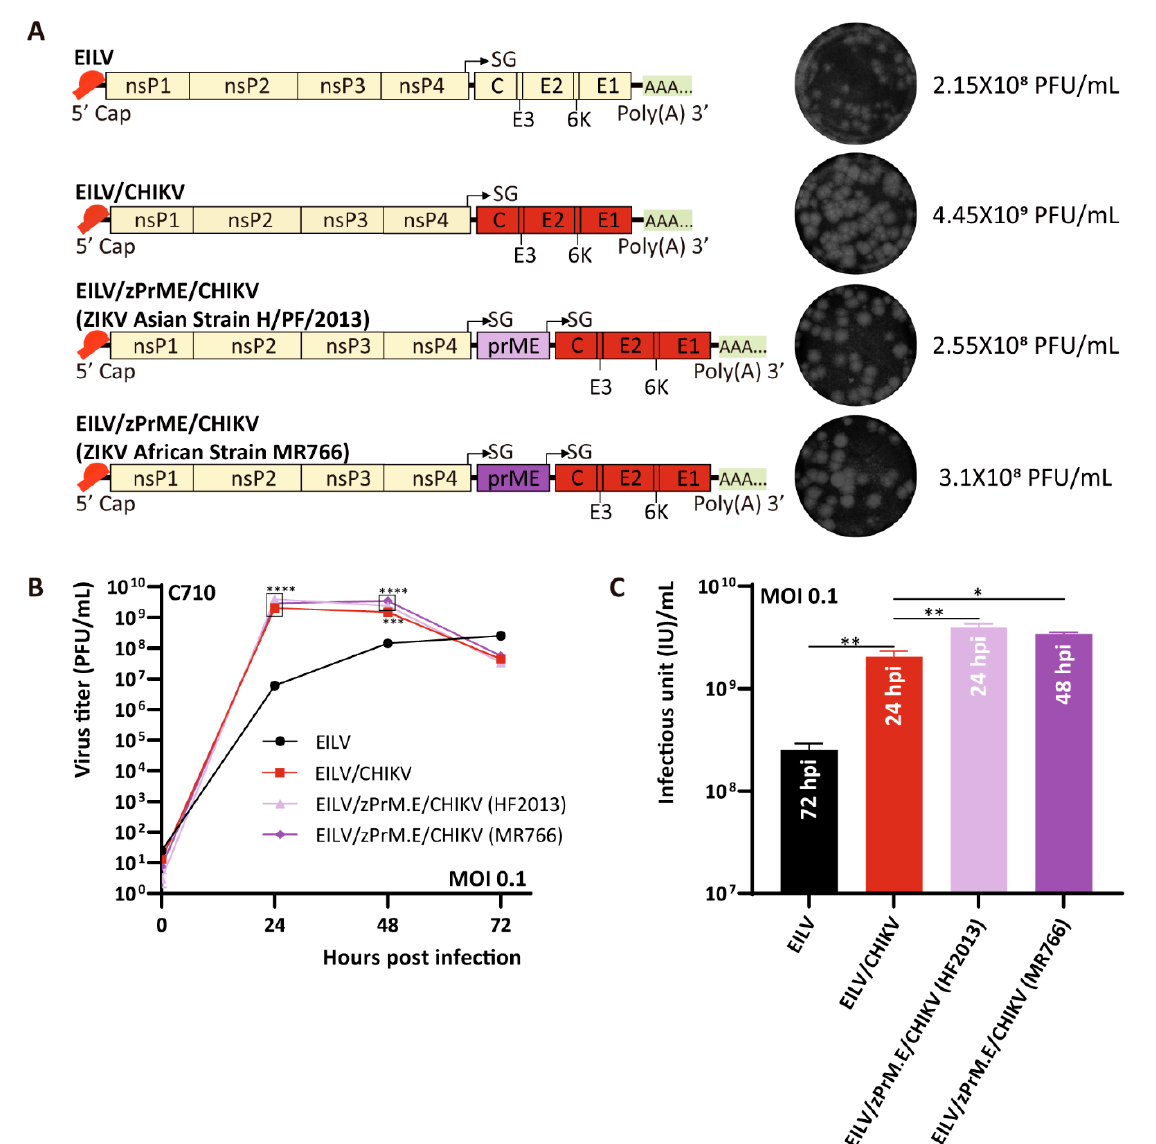
Figure 7. Genome organization and replication kinetics of EILV-based chimeric double SG variants expressing ZIKV and CHIKV antigens. ( A ) Genome organization of EILV/ ZIKV pre-membrane and envelope proteins (zPrME) /CHIKV recombinants. Viruses were rescued on C7/10 cells and harvested at 3 dpe. Rescue titers and plaque phenotypes are displayed. ( B ) Replication kinetics in C7/10 cells. Cells were infected at an MOI of 0.1. Media were collected at the indicated time points post infection, and titers were determined by plaque assay. ( C ) Comparison of the optimal titers produced by the recombinants and parental viruses. The annotation embedded in each bar in ( C ) indicates the time point reaching the highest titer. Each sample was titrated twice ( n = 2). Average titers ± SD (error bars) are shown. *, p < 0.05; **, p < 0.01; ***, p < 0.001; ****, p < 0.0001.